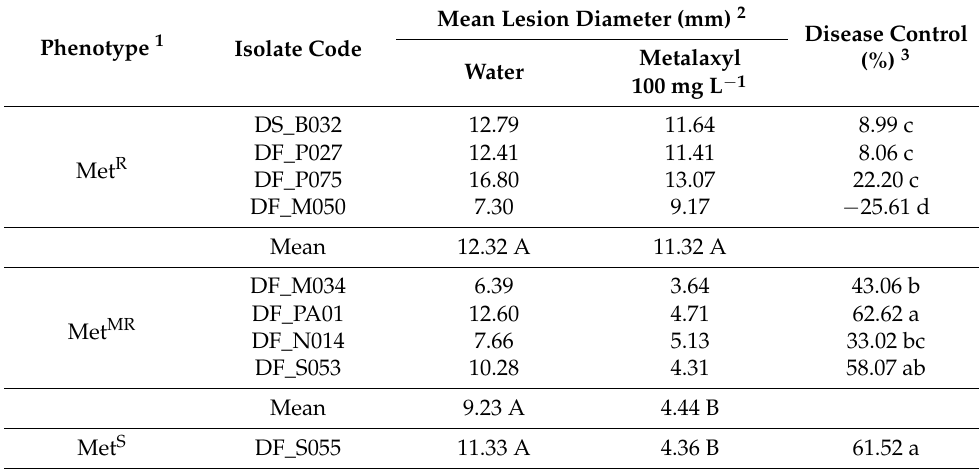
Table 3. Lesion diameters and disease control (%) on detached leaves after treatment with 100 mg L − 1 metalaxyl or water and inoculation with Phytophthora palmivora isolates for 4